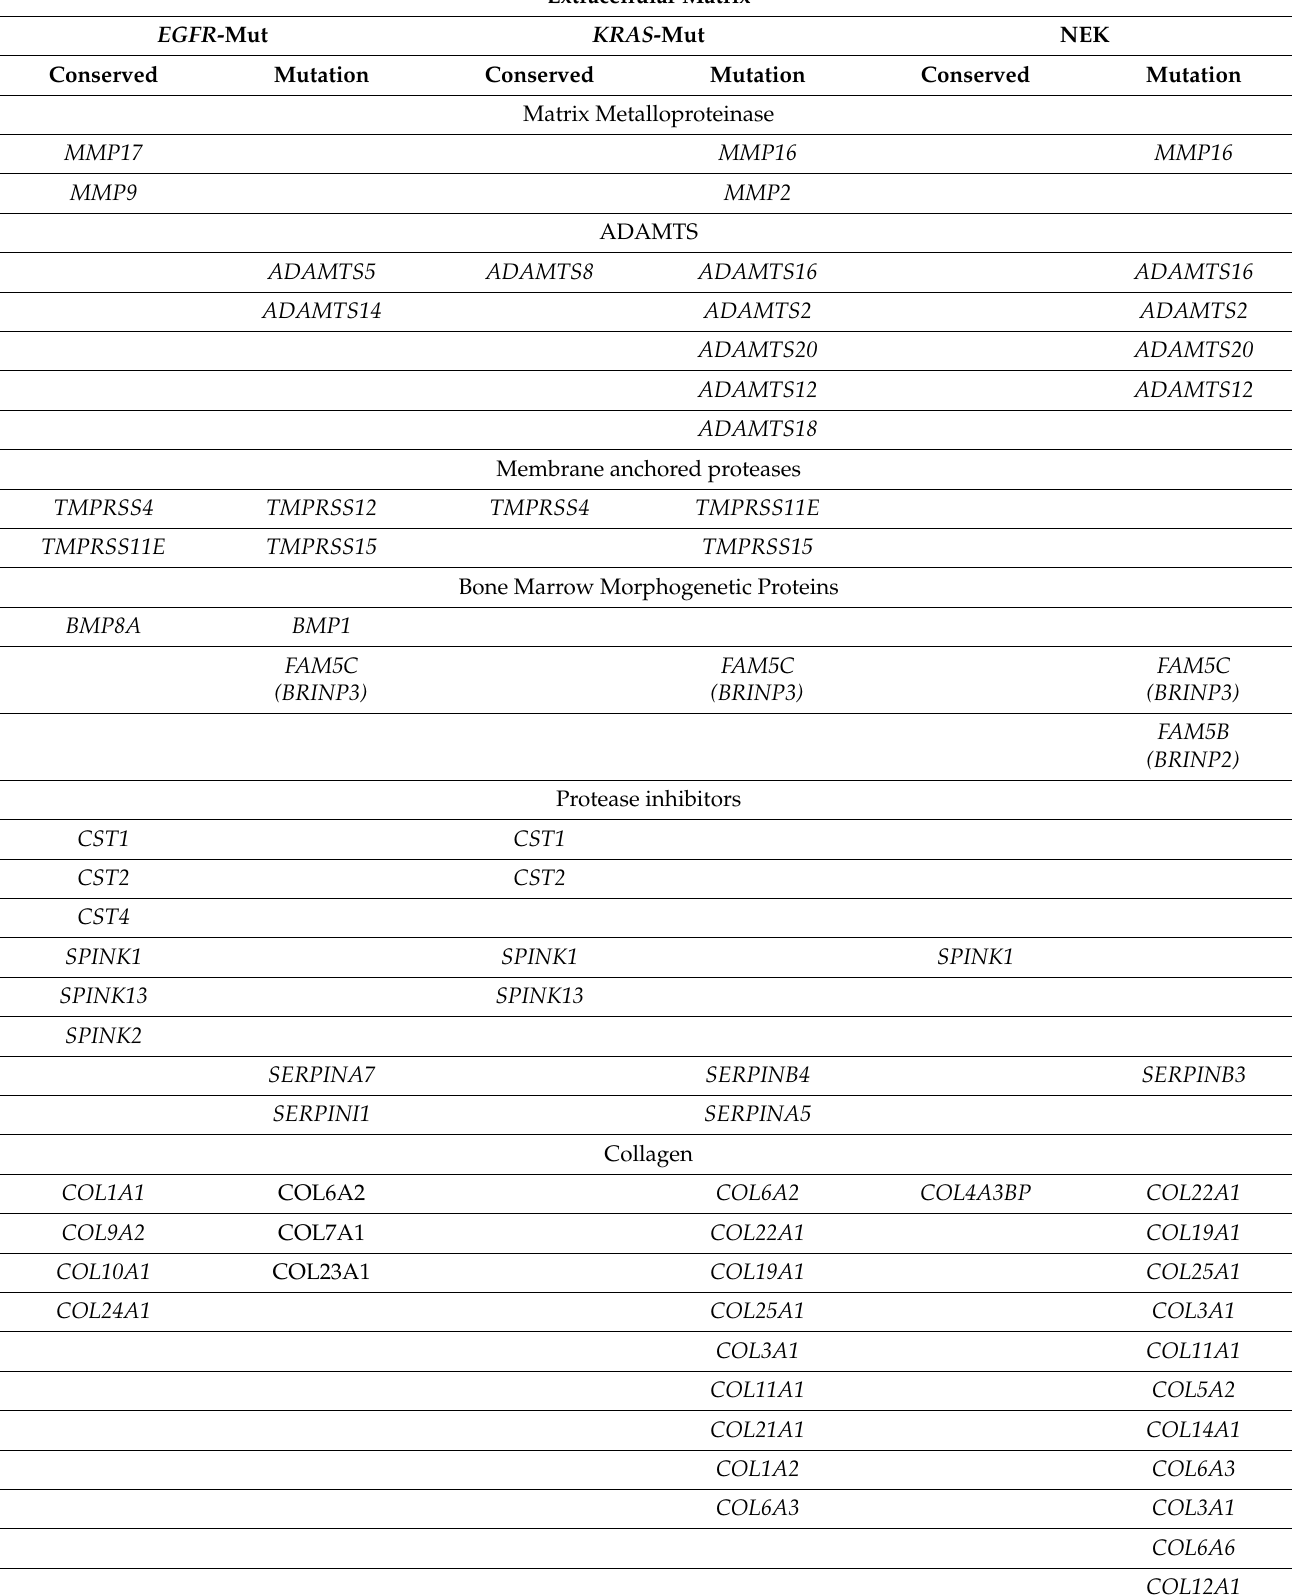
Table 3. Evolutionary selection in genes associated with the extracellular matrix. Extracellular Matrix EGFR -Mut KRAS -Mut NEK Mutation Conserved Mutation Conserved